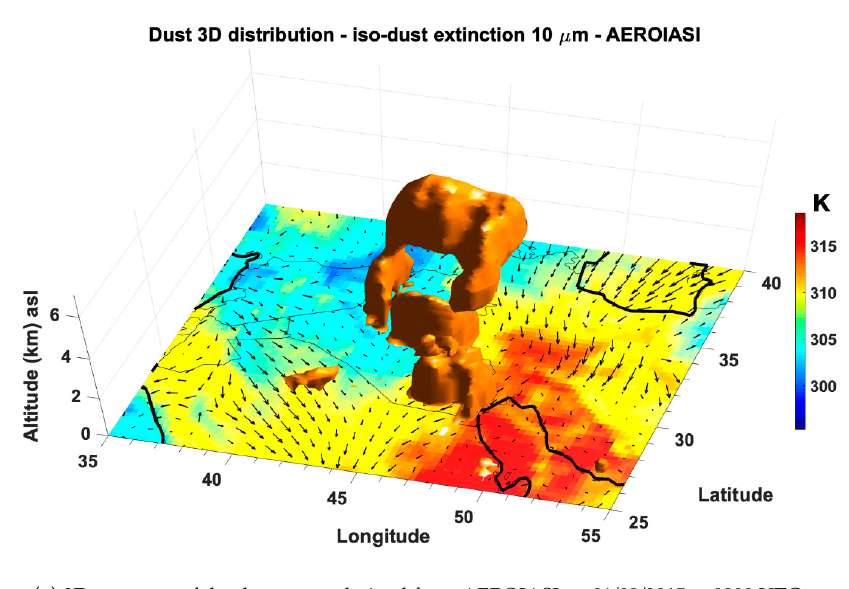
(e) 3D structure of the dust storm derived from AEROIASI on 01/09/2015 at 0900 UTC Figure 5. ( a ) SEVIRI-derived false color images showing dust (pink/purple), clouds (brown/red) and differences in surface emissivity retrieved in absence of dust or clouds (light blue/blue) on 01 September at 0900UTC. ( b ) Dust column mass density derived from MERRA2 re-analyses on 01 September at 0900UTC. On 01 September 2015 at 0900 UTC AEROIASI-derived observations of dust: ( c ) Aerosol optical depth at 10 µm, ( d ) mean height of dust layers in km and ( e ) 3D distribution of dust depicted by iso-surface of 0.1 km − 1 dust extinction coefficient at 10 µm, with ECMWF ERA5 reanalysis of potential temperature and winds at 925 hPa.